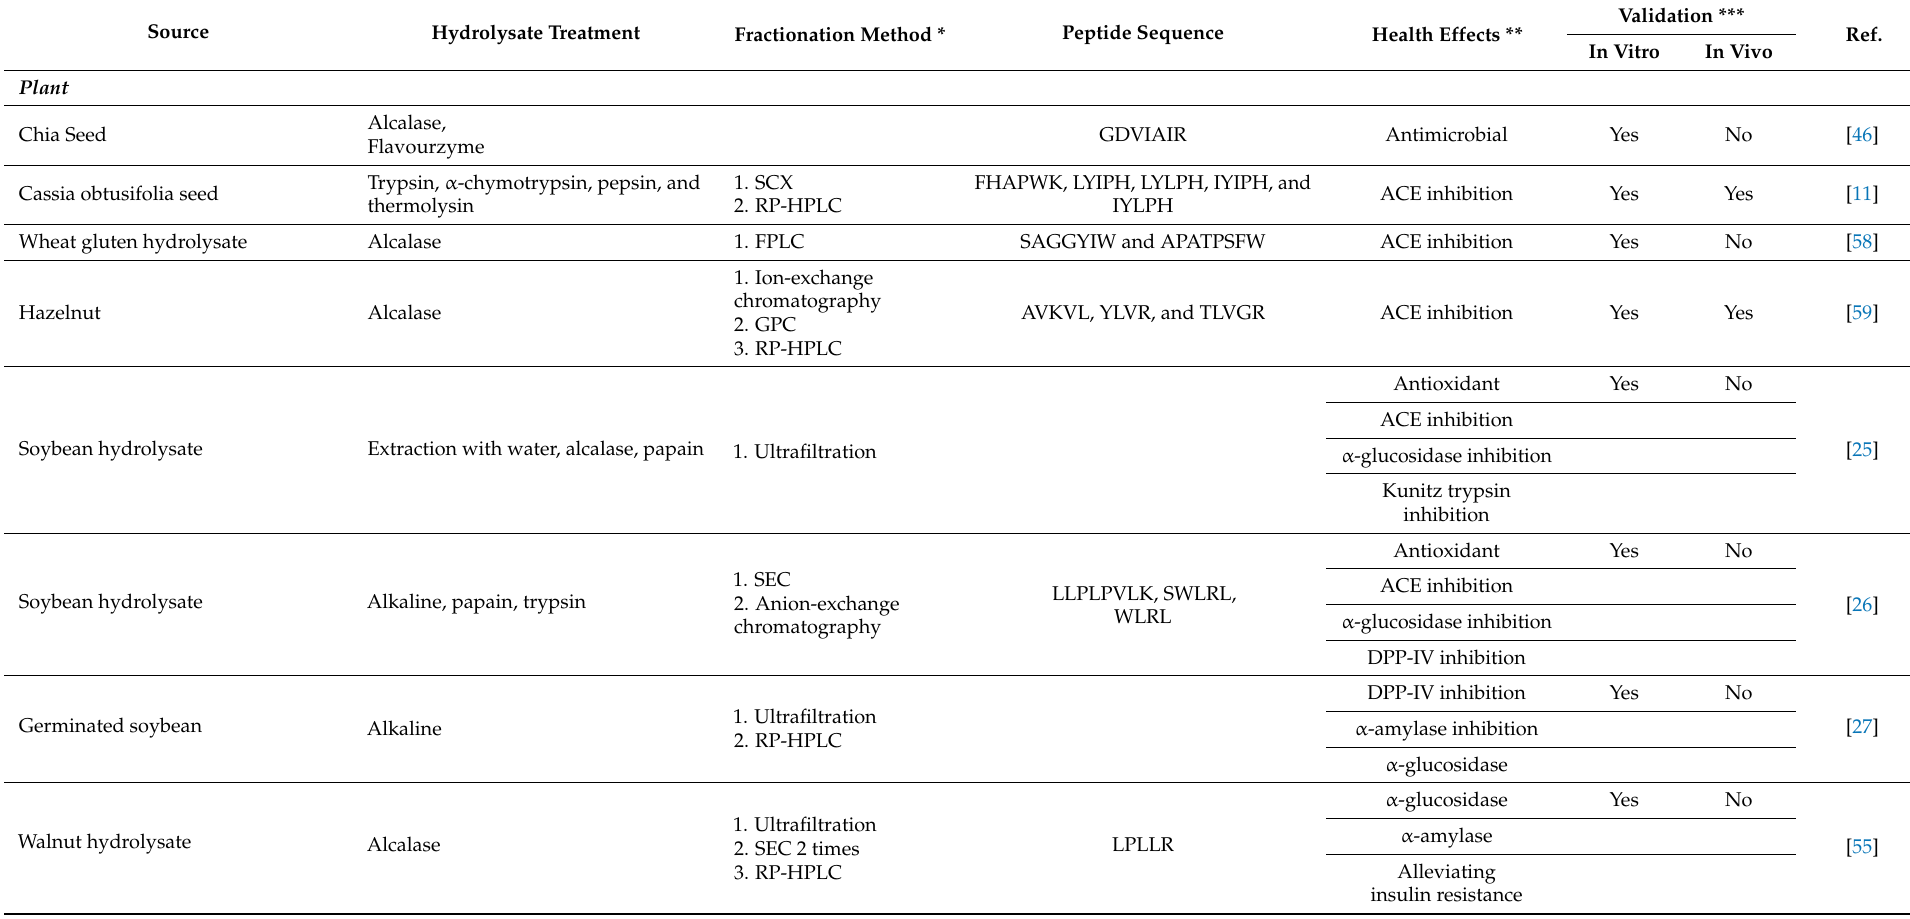
Table 1. Summary methods on functional properties of bioactive peptides fractionation and